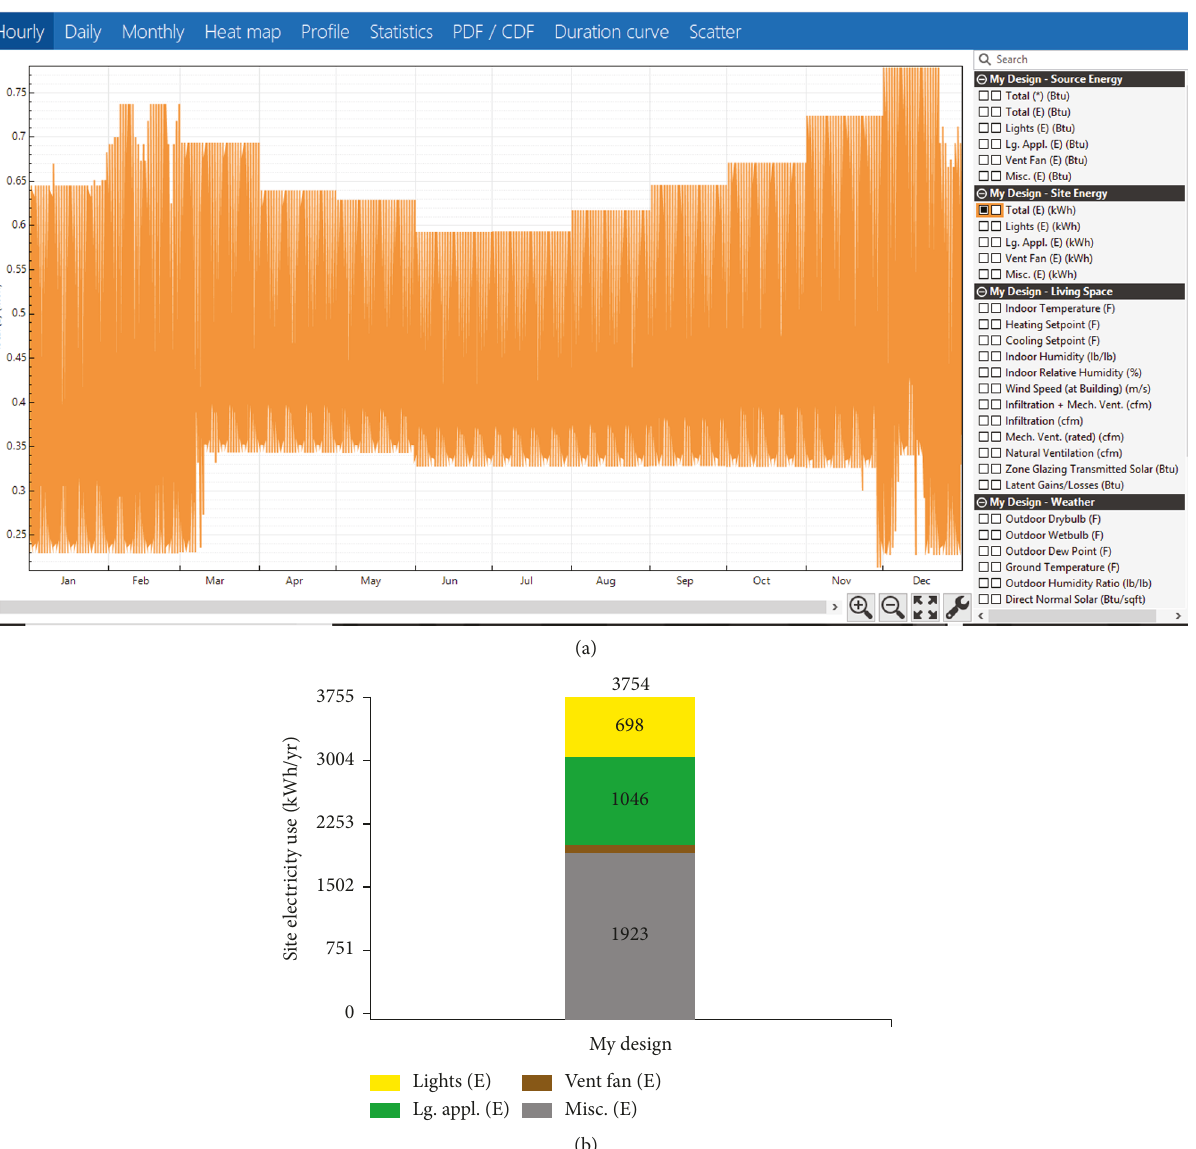
Figure 3: (a) Hourly load fl ow data of the house for a typical year. (b) Annual energy consumption of the house by di ff erent types of load (lights, large appliances, ventilation fans, and miscellaneous